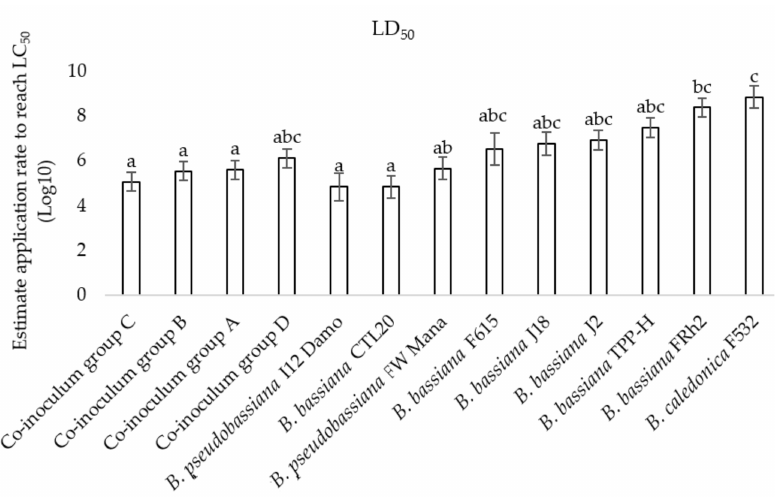
Figure 5. LC50 for the four combinations of isolates compared to the individual isolates (error bars following letters represent ANOVA; multiple comparisons using Tukey’s HSD test) (F2, 12 = 6.47, p =